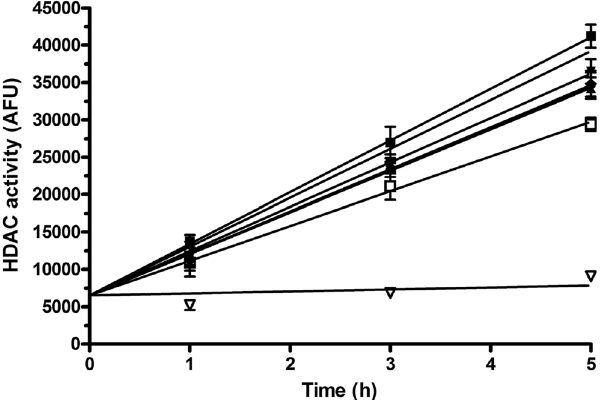
Figure 3. Activity of HDAC enzymes in HCT-116 cells treated with the compounds tested in the present work; their concentration was 1 µ M except the concentration of free OA, which was 1 mM. Symbols: ■ , control; ▲ , Pt(IV)diOA; ▼ , Pt(IV)AcOA; &#x29EB;, Pt(IV)diAc; ● , cisplatin; □ , OA (1 mM); ▽ , trichostatin A (well known HDAC inhibitor used as the positive control). The data represent a mean from three independent experiments, each performed in quadruplicate. The error bars are the